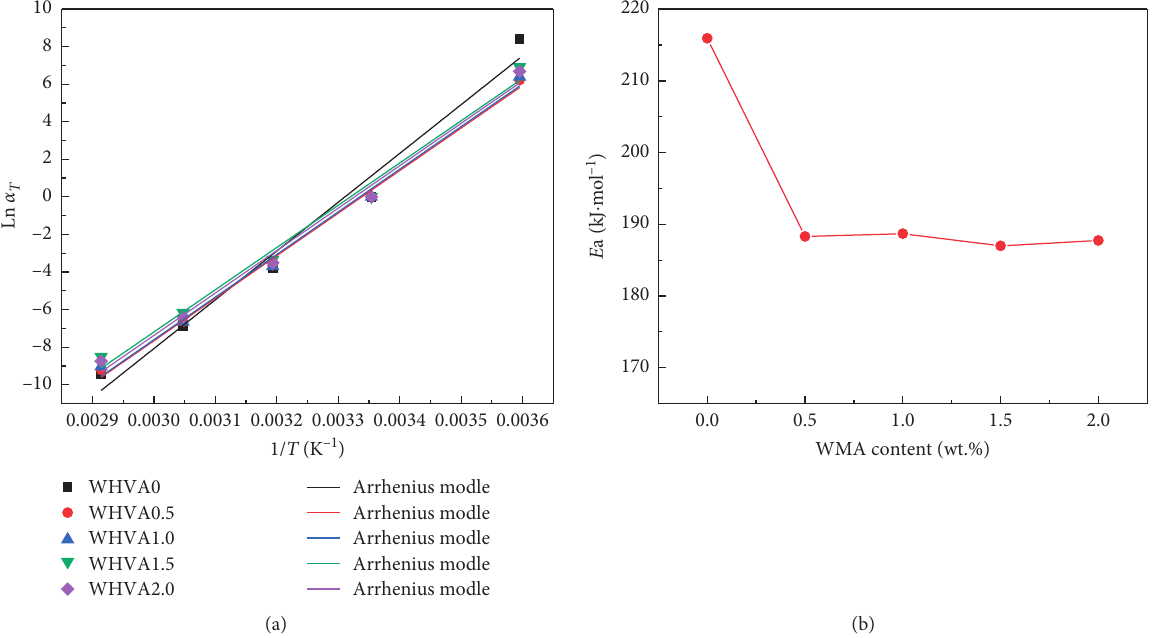
Figure 4: (a) Evolutions of shift factors versus temperature and (b) variations of activation energy as a function of WMA contents for warm- mix